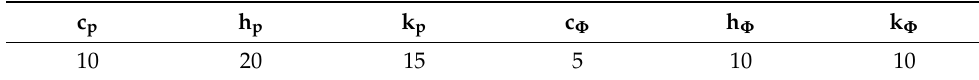
Table 2. Control